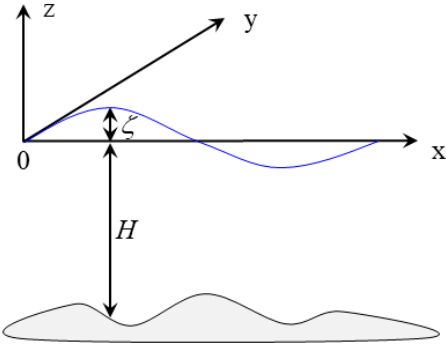
Figure 1. Illustration of the orthogonal Cartesian coordinate system.